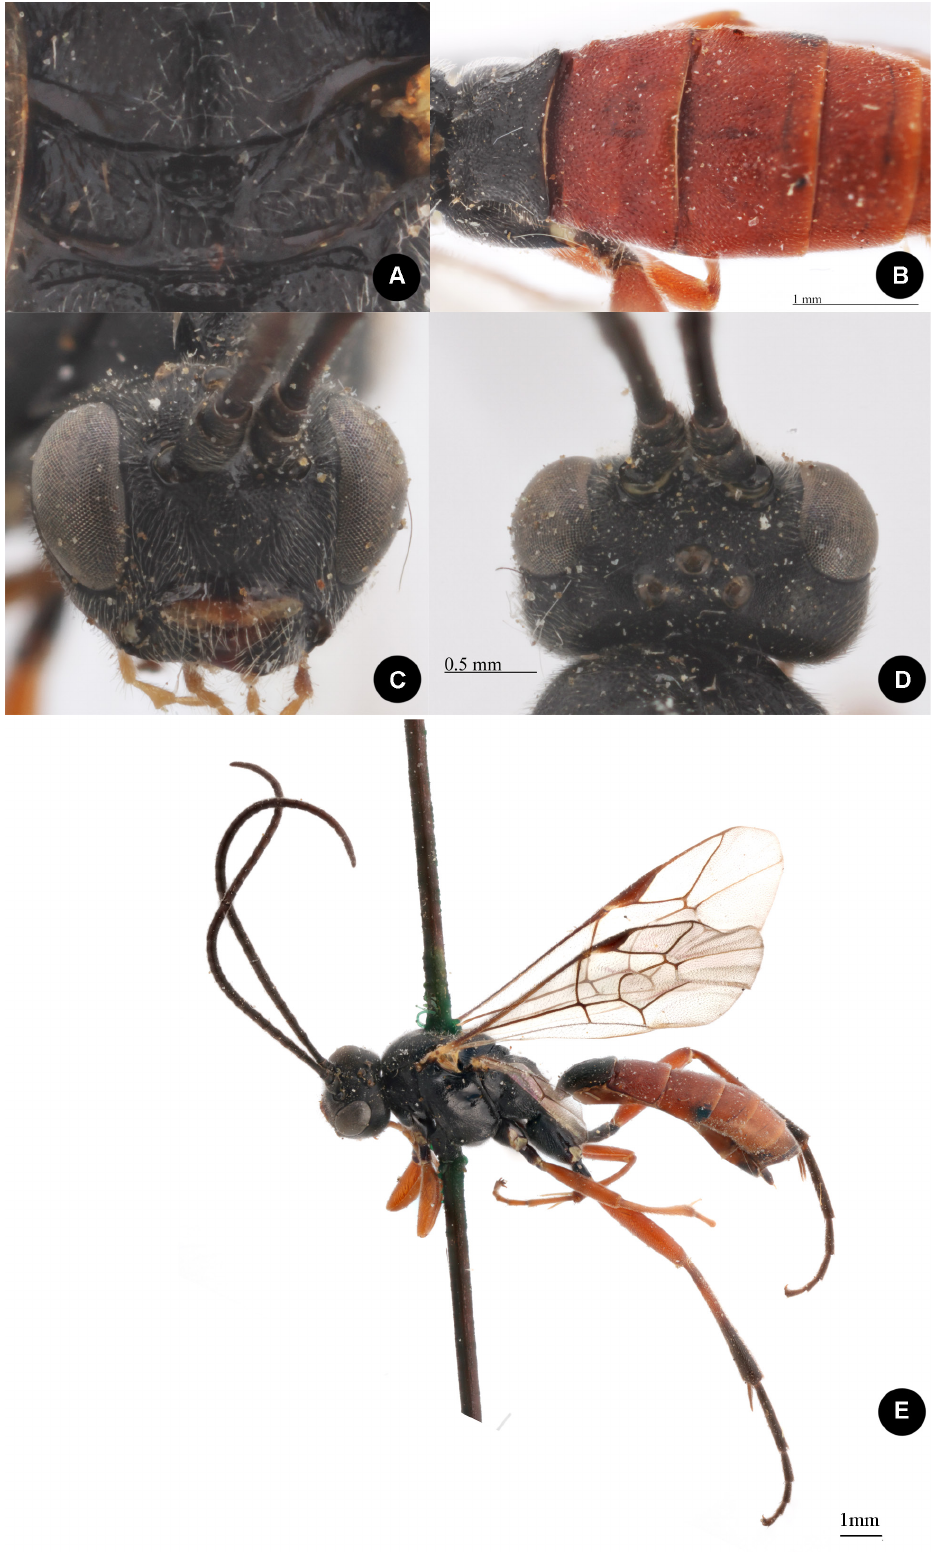
Fig. 8. Rhinotorus longicornis (Schmiedeknecht, 1914). A . Mesoscutellum. B . Metasoma dorsally. C . Face. D . Head dorsally. E .